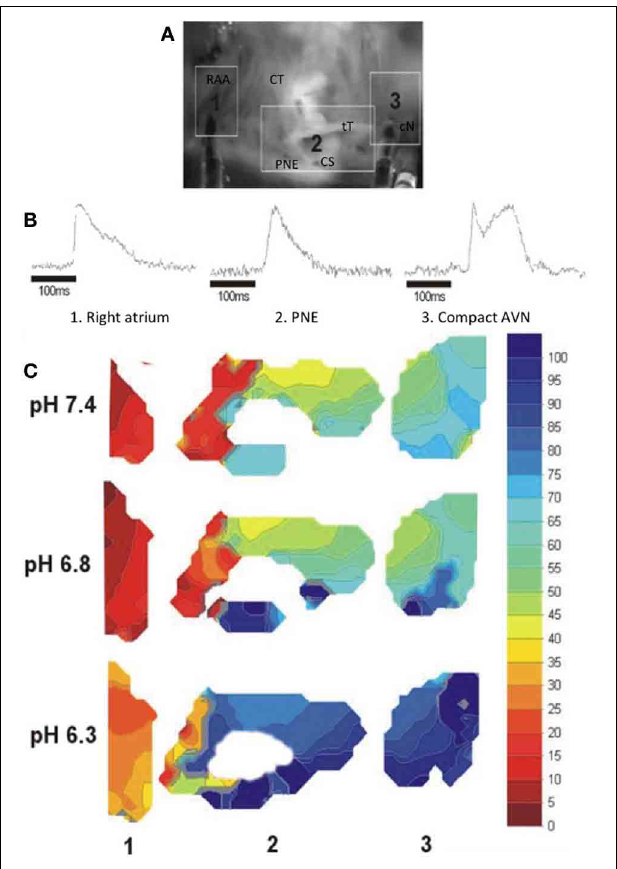
FIGURE 3 | (A) CCD image of an isolated right atrial preparation, the areas shown correspond to: Region 1: right atrium in region of the pectinate muscles of the right atrial appendage (RAA) to the crista terminalis (CT); Region 2: Tendon of Todaro (tT) and posterior nodal extension (PNE) surrounding the mouth of the coronary sinus (CS); Region 3: Compact AVN (cN) and His bundle region at the apex of the triangle of Koch. (B) Typical optical action potentials from the isolated AV node preparation at normal pH in the regions shown in (A) . The multi-component signal at region 3 represents initial compact nodal activation followed by ventricular activation in this complex multi-layered region (Efimov and Mazgalev, 1998). (C) Isochronal maps of activation showing conduction delay with reducing pH. Local activation times were measured relative to the onset of the atrial electrogram. Isochronal crowding occurred at the junction of the RA and the posterior nodal extension, with marked delay along the PNE region corresponding anatomically to the slow pathway (Choi and Salama,